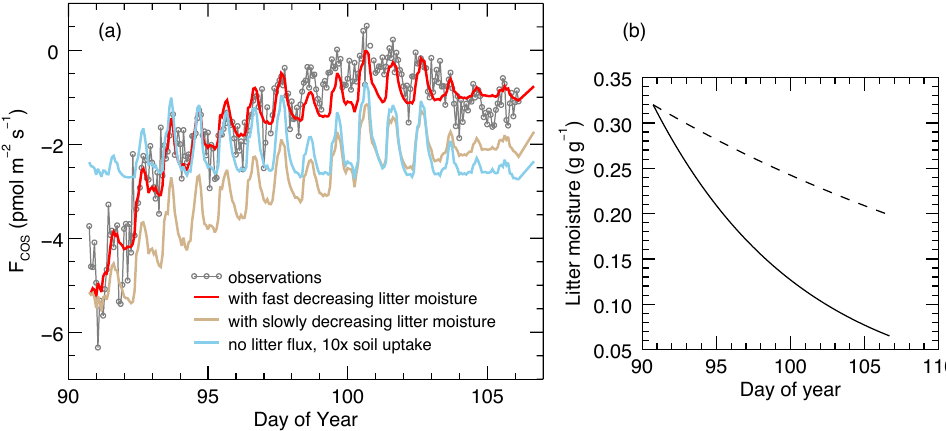
Figure 8. (a) Simulated COS fluxes at the Stunt Ranch site for three scenarios, compared with the observations: fast decreasing litter moisture (red), slowly decreasing litter moisture (light brown), and no litter flux but 10 × soil uptake (light blue). (b) Changes in litter water content for the fast loss (solid) and slow loss (dashed)